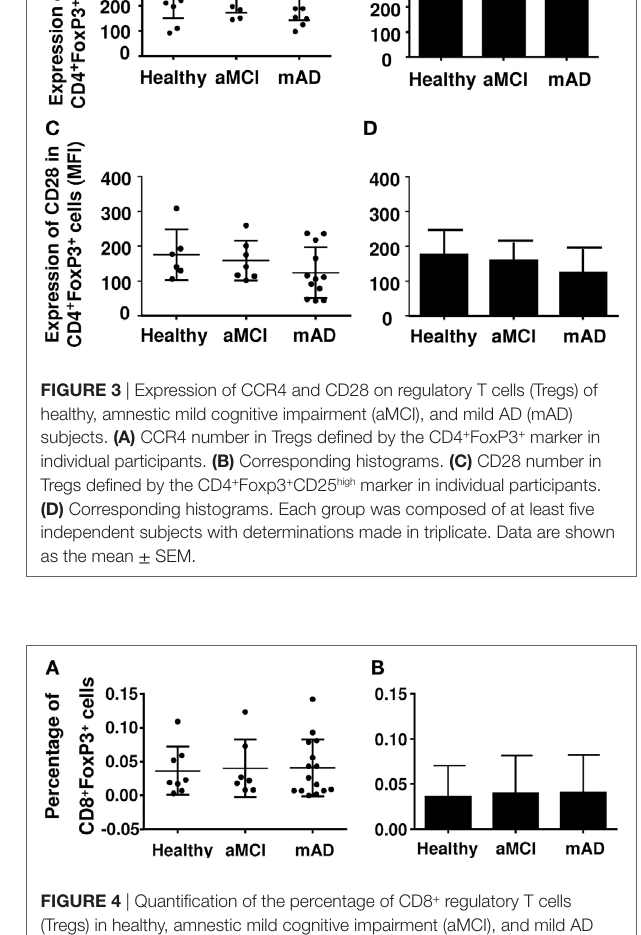
FigUre 4 | Quantification of the percentage of CD8 + regulatory T cells (Tregs) in healthy, amnestic mild cognitive impairment (aMCI), and mild AD (mAD) subjects. (a) Percentage of CD8 + FoxP3 + Tregs in individual participants. (B) Corresponding histograms. Each group was composed of at least five independent subjects with determinations made in triplicate. Data are shown as the mean ± SEM.